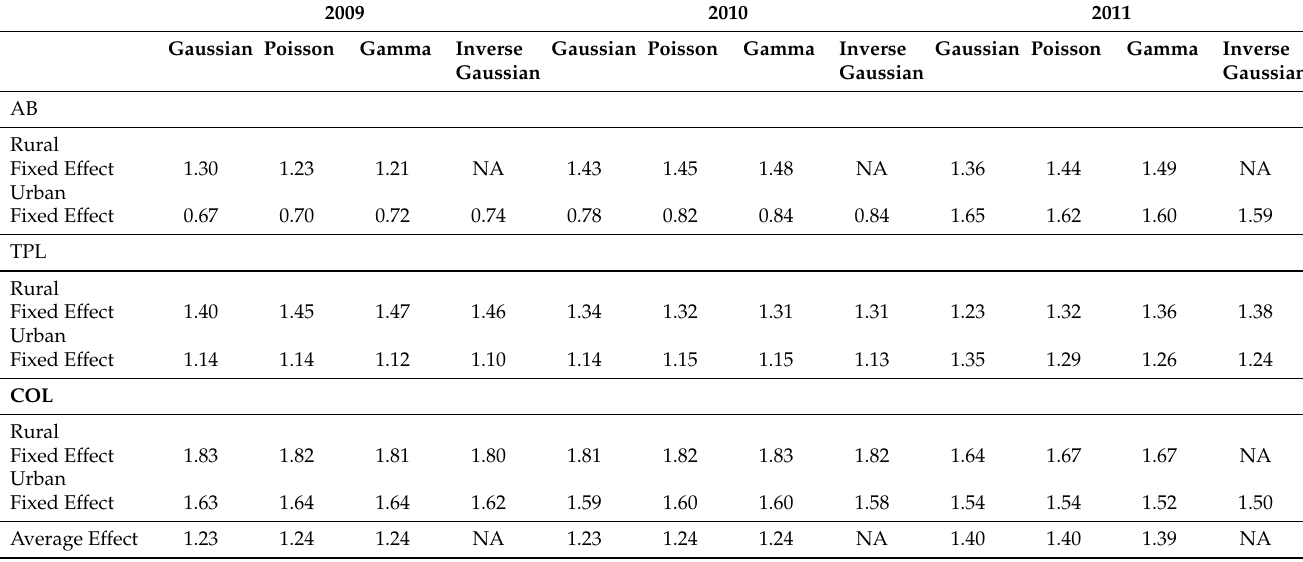
Table 7. The combined fixed effect estimates for DR and CLASS, separated by year, coverages and region, obtained from the two-way